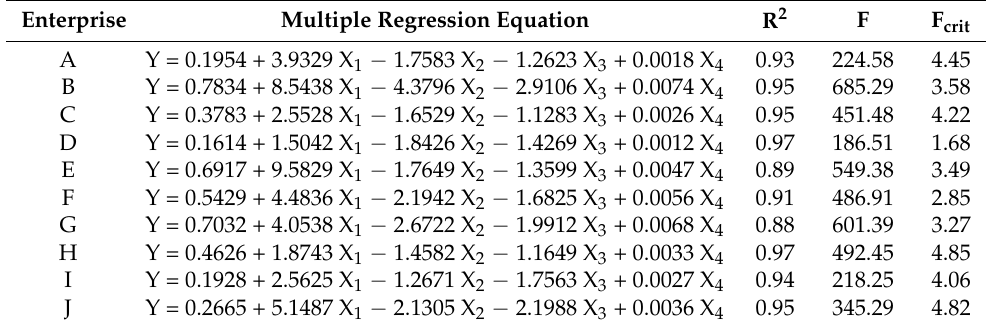
Table 1. Regression models of the level of financial competitiveness for the studied mining companies.